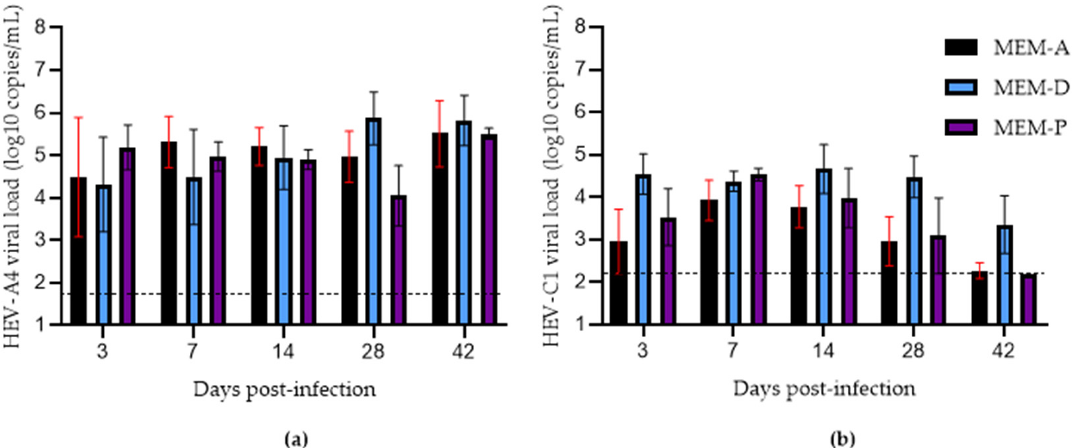
Figure 4. Growth of hepatitis E virus (HEV) in PLC/PRF/5 cells maintained in MEM-A and MEM-D and MEM-P for ( a ) HEV-A genotype 4 (HEV-A4) and ( b ) HEV-C genotype 1 (HEV-C1) variants. Each data point represents the mean of 3 replicates. Error bars represent standard error of mean. Limit of detection of the RT-qPCR assay is represented by the dashed line (50 and 160 copies per mL for HEV-A4 and HEV-C1, respectively).